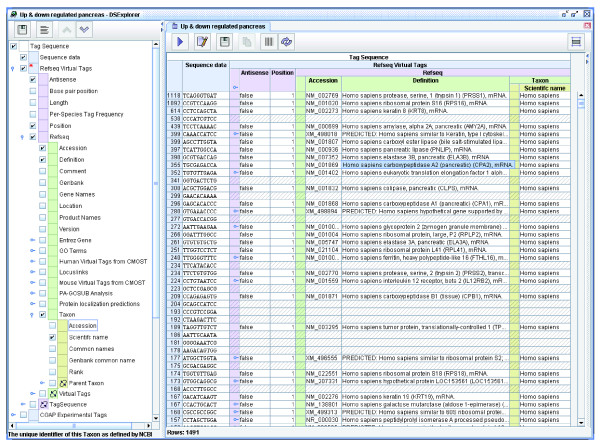
A screenshot of the DiscoverySpace Explorer. The Explorer comprises one 'view', which describes the cross-section of data required by the user, and one or more datasets, which provide the initial starting content. The view is displayed in the left panel of the Explorer and graphically represents all navigable paths as a tree of sets cascading from the root class (much like the data model from Figure 2). Some properties have a literal object, such as a name, a sequence or a comment field. Others are links to associated resources such as genes, proteins or pathways. The view determines the content being displayed in the main table of the Explorer; each property in the tree has a checkbox that is used to include or exclude the property as a column. The right panel of the Explorer holds the main display. Each dataset added to the Explorer is represented by a tab containing a table. Each table displays the member resources of the selected dataset (and their weight values) as rows. The properties of the resources, and the properties of associated resources, are represented as columns, as determined by the view. The table, with its novel nested header, reflects the structure and the color-coding of the view in the left panel. If no view is specified by the user then a default view is created from the class of the dataset. All datasets in an Explorer session must have the same data type, and that class must be shared by the root node of the view. In the example above the user has constructed a view consisting of a path from the root set of tag sequences 'Up & down regulated pancreas' through virtual tags from Refseq to their counterpart Refseq genes. Additionally, the user has restricted the set of linked virtual tags to only those from human Refseq (multi-species joins are supported by the data model) and only those tags at position one (closest to the 3' end) on the sense strand. The result of the mapping operation, a set of human Refseq genes, can be selected and dragged out of the Explorer for further interpretation. The frequency, or weight, is displayed on the left hand side of each tag sequence.